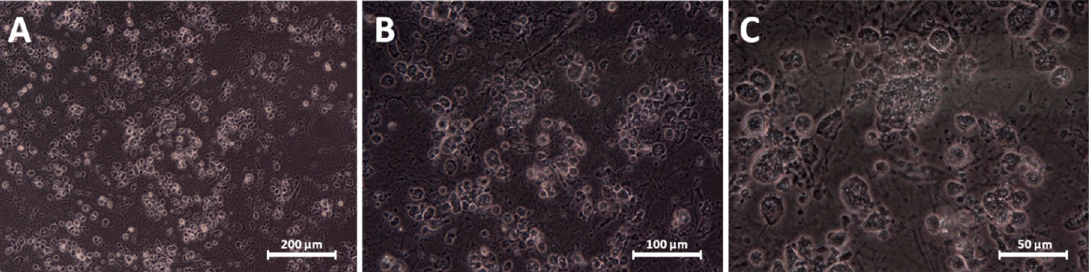
Figure 7. Morphology of cardiac progenitor cells cultured with the addition of 10 μ g/mL AgNP after 48 h. Magnifications: ( A ) 100 × ; ( B ) 200 × ; ( C ) 400 × .